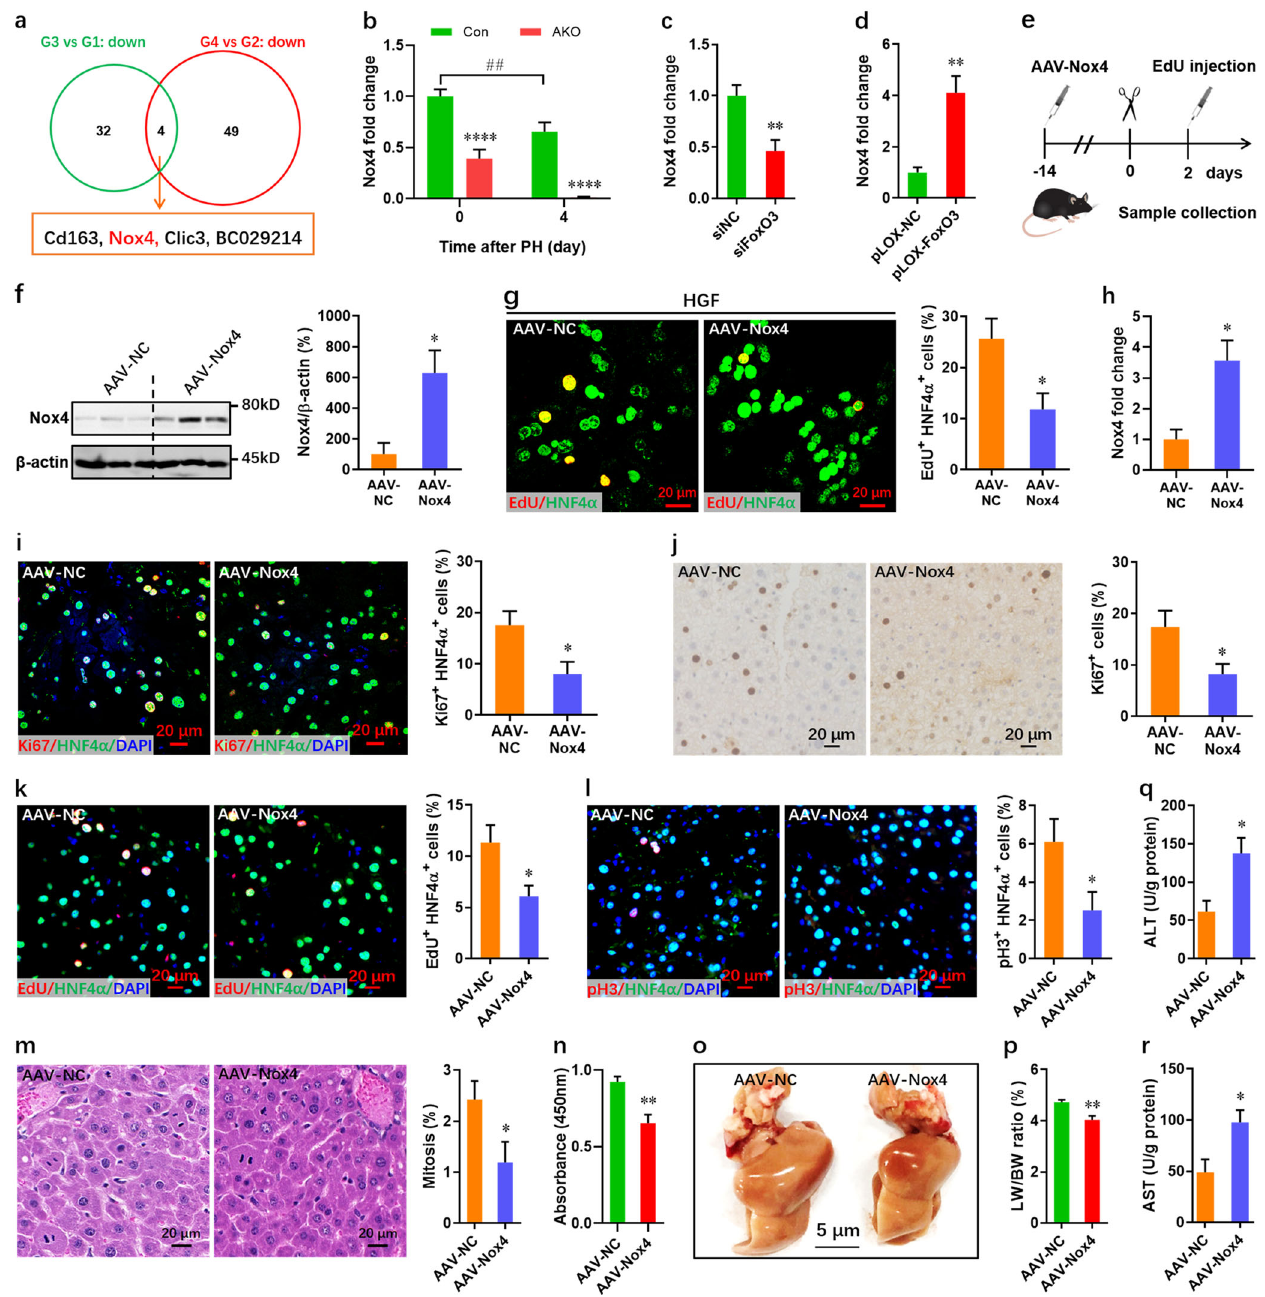
Fig. 8 FoxO3 de fi ciency-induced hepatocyte proliferation exhibits a strong correlation with Nox4 downregulation. a RNA-seq identi fi ed 4 overlapping downregulated genes in AKO mice pre- and post-PH compared with control mice. G1, control mice pre-PH; G2, control mice post- PH; G3, mutant mice pre-PH; G4, mutant mice post-PH. b qPCR validation of the downregulated expression of Nox4 in FoxO3 -knockout mice compared with control mice before and after PH ( n = 8 mice per group). c Downregulation of Nox4 expression in FoxO3 -de fi cient NCTC1469 cells ( n = 5 per group). d Upregulation of Nox4 expression in FoxO3 -overexpressing NCTC1469 cells ( n = 5 per group). e Schematic of AAV- Nox4 injection in adult AKO mice for 2 weeks, followed by primary hepatocytes isolation at 0 dpH or PH performance and EdU injection at 2 dpH. f , g Isolated primary hepatocytes at 0 dpH were treated with HGF (40 ng/ml) for 4 days in MHGM, followed by Western blotting assay (f, n = 3 mice) and EdU/HNF4 α double staining (g, n = 6 mice). h qPCR validation of Nox4 expression in livers from AAV-NC and AAV-Nox4 mice ( n = 3 mice). i Representative images (left) and quanti fi cation (right) of Ki67 + HNF4 α + cells in AAV-NC and AAV-Nox4 mice at 2 dpH ( n = 6 mice). j Representative images (left) and quanti fi cation (right) of Ki67 + cells in liver at 2 dpH ( n = 6 mice). k Representative images (left) and quanti fi cation (right) of EdU + HNF4 α + cells in AAV-NC and AAV-Nox4 mice at 2 dpH ( n = 6 mice). l Representative images (left) and quanti fi cation (right) of pH3 + HNF4 α + cells in livers at 2 dpH ( n = 6 mice). m Representative images (left) and quanti fi cation (right) of mitotic hepatocytes in livers at 2 dpH ( n = 6 mice). n Cell counting assay for primary hepatocytes isolated from livers at 2 dpH ( n = 6). o Representative images of livers at 2 dpH. p The actual ratio of liver/body weight at 2 dpH ( n = 6 mice). q and r Liver ALT ( q ) and AST ( r ) levels in AKO mice injected with AAV-NC and AAV-Nox4 at 2 dpH ( n = 3 mice). All data are presented as the mean ± SEM, * p < 0.05, ** p < 0.01, *** p < 0.001 versus controls (two-way ANOVA test for b; Student ’ s t -test for c, d,